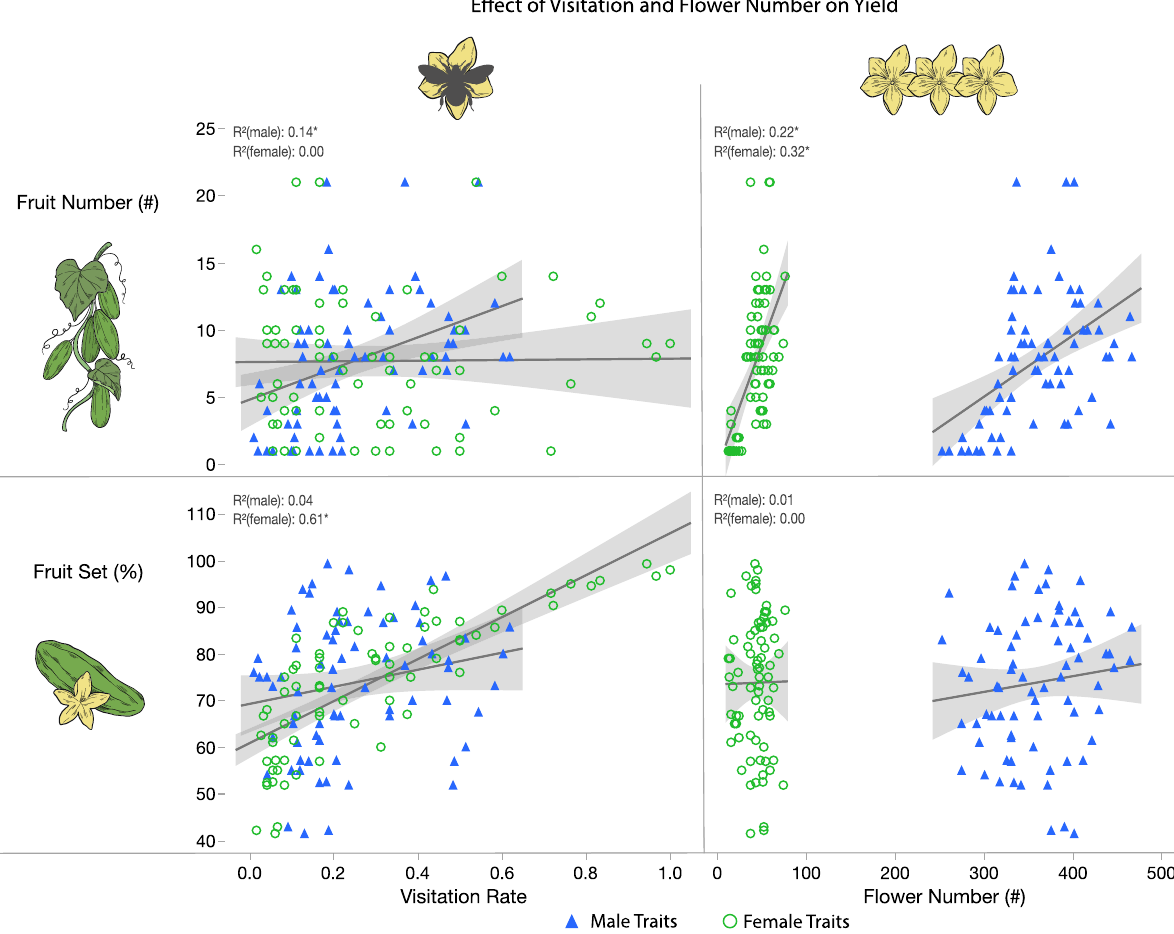
Figure 4. The effects of bee visitation rate and flower number on cucumber yield (Supplementary Table S5). Each marker represents an individual plant colored and shaped by male (blue triangles) or female (green circles) flowers. Note that fruit number was strongly influenced by flower number while fruit set (number of fruit per number of flowers per plant) was strongly influenced by female flower visitation